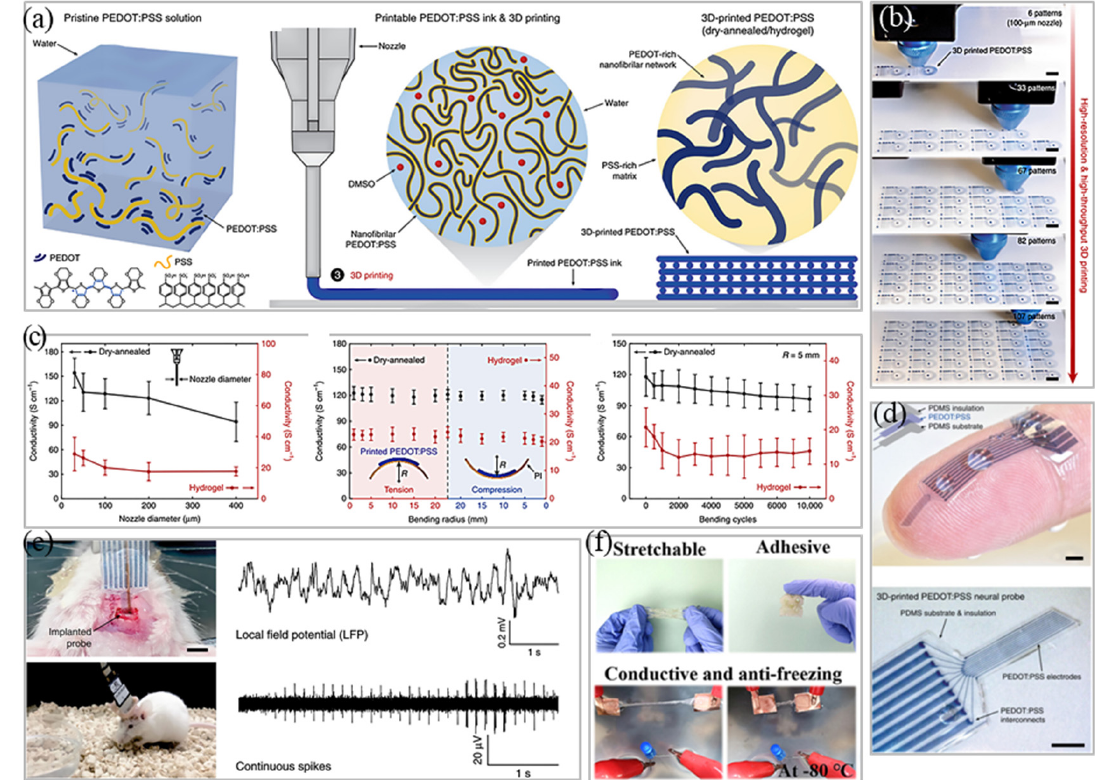
Figure 8. A summary of preparation strategies for electrical physiology electrodes based on 3D printing. ( a ) Design of 3D printable conducting polymer ink. ( b ) Sequential snapshots for 3D printing of high-density flexible electronic circuit patterns by the conducting polymer ink. ( c ) Conductivity as a function of nozzle diameter for 3D-printed conducting polymers in dry and hydrogel states; conductivity as a function of bending radius; conductivity as a function of bending cycles. ( d ) Image of the 3D-printed soft neural probe with nine channels by the conducting polymer ink and the PDMS ink. ( e ) Images of the implanted 3D-printed soft neural probe (left) and a freely moving mouse with the implanted probe; representative electrophysiological recordings in the mouse dHPC by the 3D-printed soft neural probe (right). ( a – e ) are reproduced with permission from [106]. Copyright 2020, The Authors. ( f ) Conductive hydrogel performance based on 3D-printing technology in extreme environments. Reproduced with permission from [154]. Copyright 2021, Elsevier.